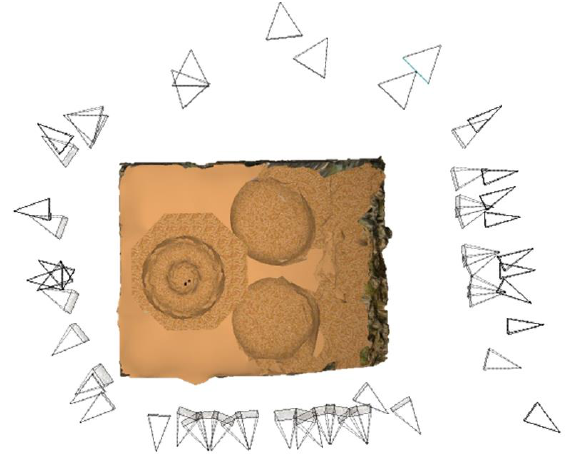
Figure 7. Placement of cameras for the exterior surfaces of the